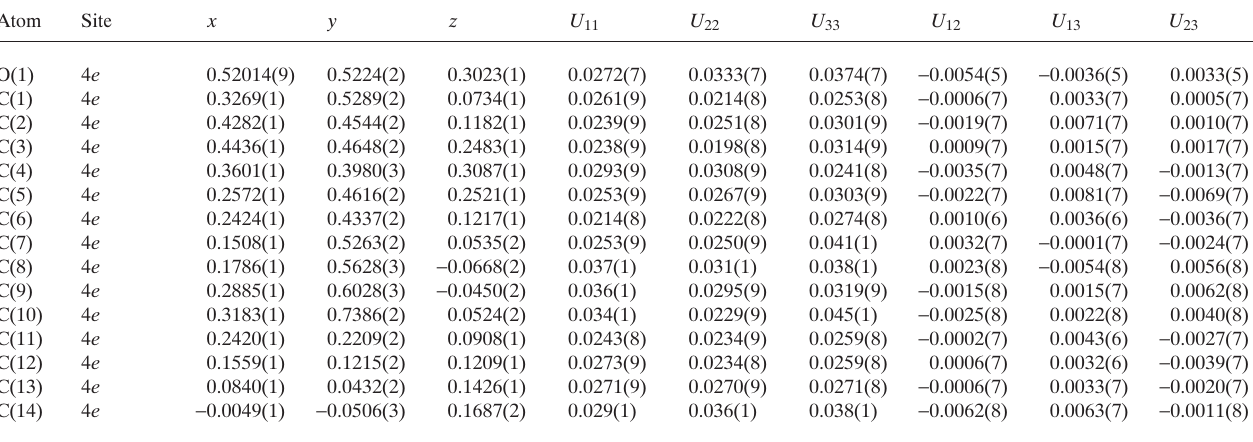
Table 3. Atomic coordinates and displacement parameters (in Å 2 )